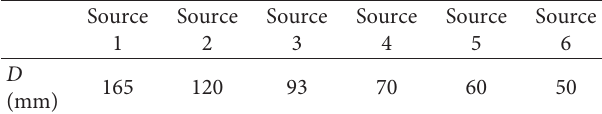
Table 1: Diameters of the sources of the fire tested in the ex- perimental